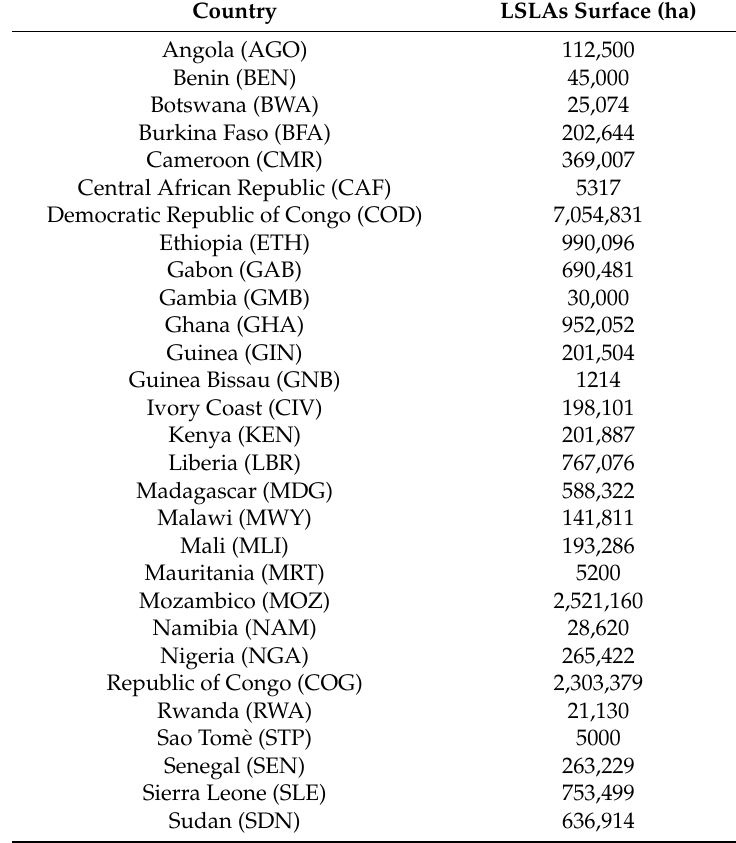
Table 2. Large-scale land acquisitions (LSLAs) surfaces of the sample